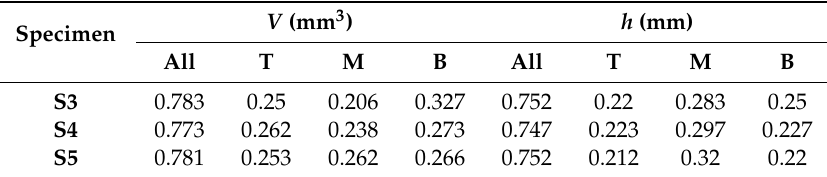
Table 4. Calculated values for h n , d s and ε of specimens S3–S5.